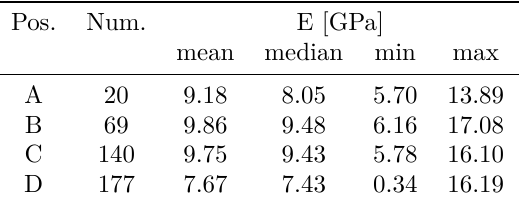
Table 3. Young’s moduli from tensile test according to failure position.